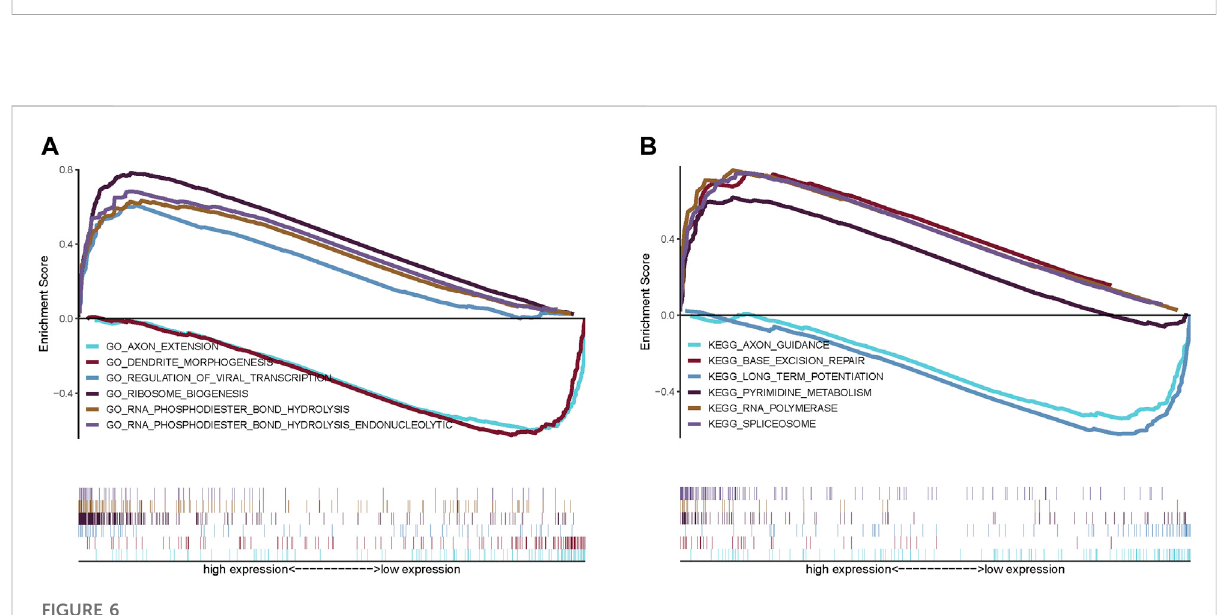
FIGURE 5 Externalvalidationofthehypoxiariskscore. (A,B) ValidationofthehypoxiariskscoreinGSE62564; (C,D) ValidationofthehypoxiariskscoreinGSE85047.